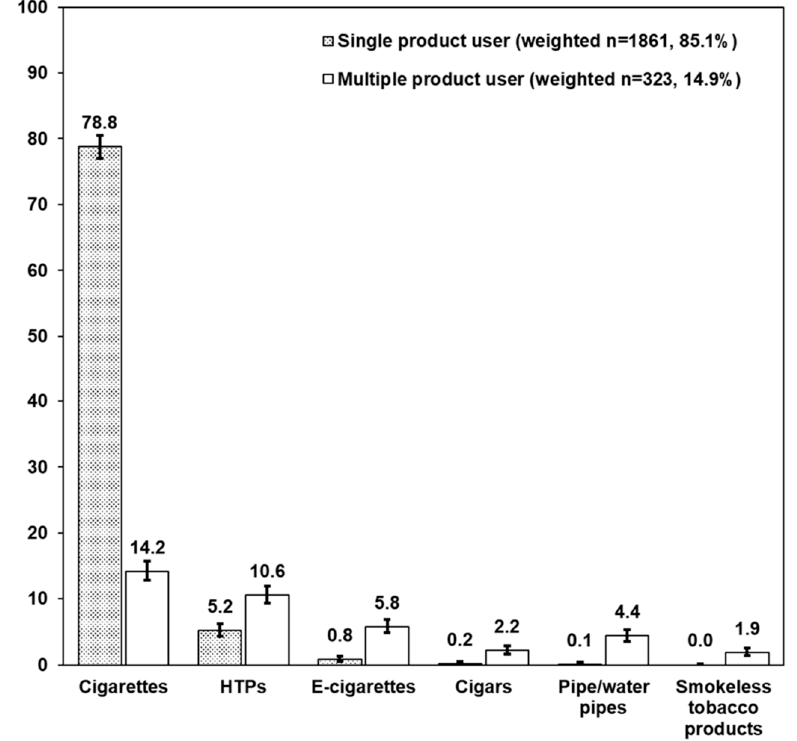
Figure 1. Percentages of tobacco and tobacco-like products use among current product users (weighted n = 2183, 100%). Error bars represent 95% confidence interval.